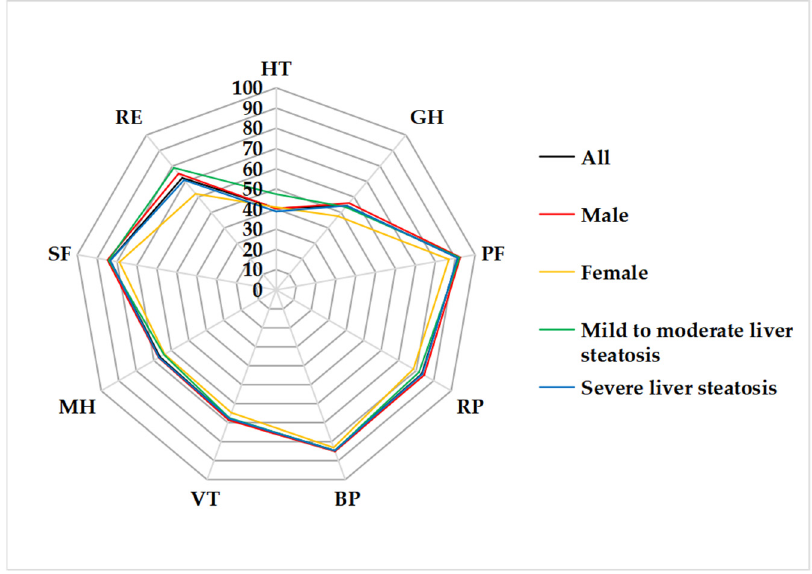
Figure 2. Radar chart of QoL scores in different dimensions with NAFLD patients. VO 2 max levels were lower than average in 91.5% of males and 80.0% of female NAFLD patients. There were 48.8% of male patients and 50% of female patients with GS lower than grade 3 (medium level). Meanwhile, there were 86.6% of male patients and 59.1% of female patients with SFF lower than grade 3 (medium level). No patient achieved grade 5 of SFF (Table